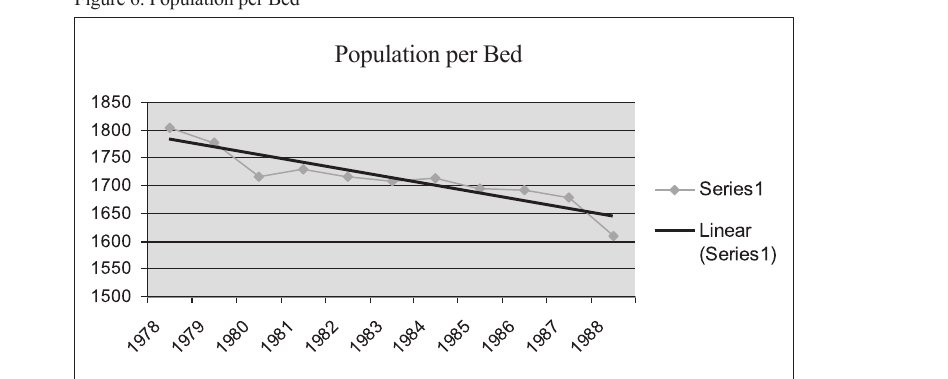
Figure 6. Population per Bed